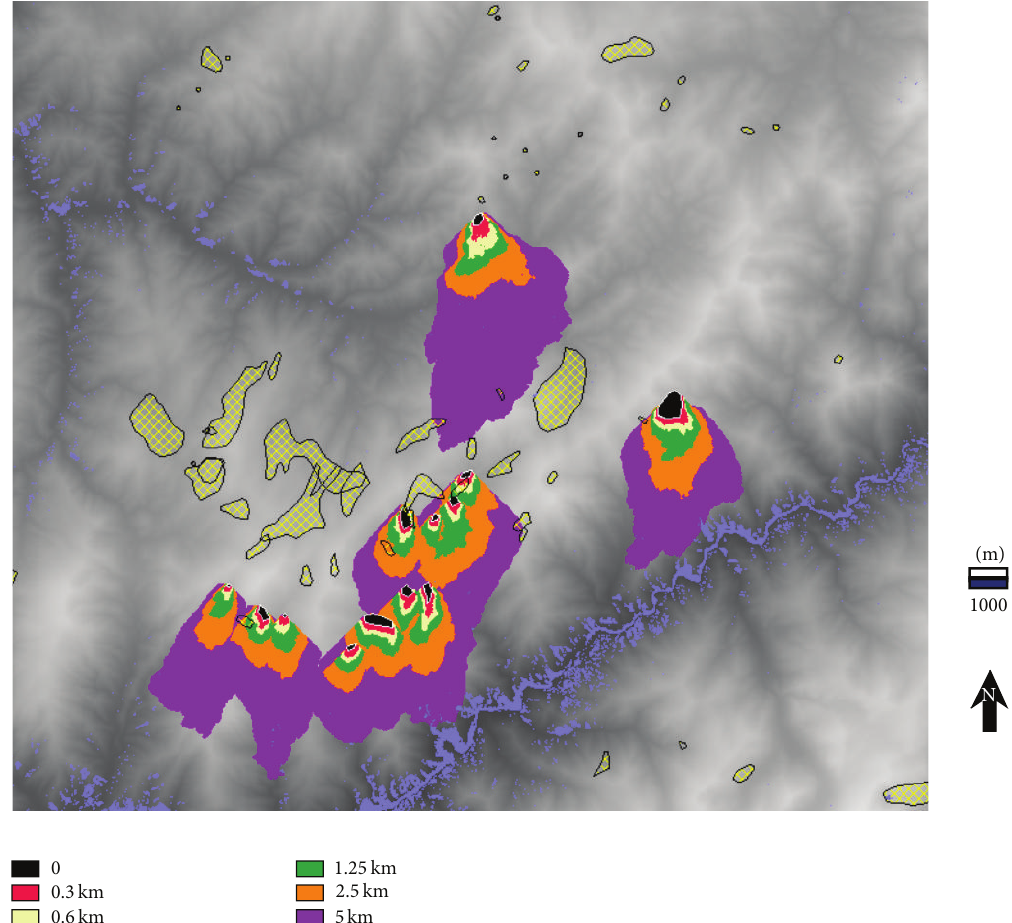
Figure 4: July wind dispersal model showing BWA (yellow crosshatched = BWA infestations found 12 to 16 years after initial survey, blue represents area unlikely to have subalpine fir, and background layer is elevation). Location shown in Figure